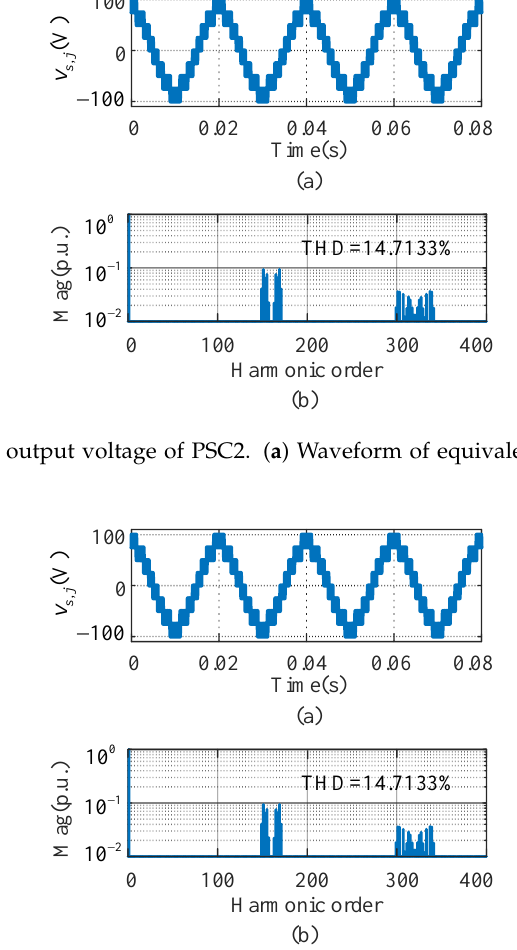
Figure 11. Theoretical output voltage of PSC3. ( a ) Waveform of equivalent output-phase voltage; ( b ) FFT